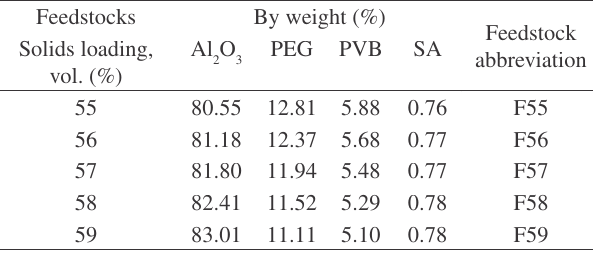
Table 2. Composition of feedstocks.